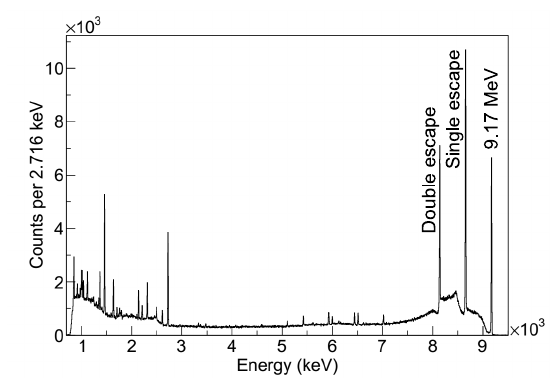
Figure 2. Sample spectrum of 13 C(p, γ ) 14 N resonance detected by HPGe detector